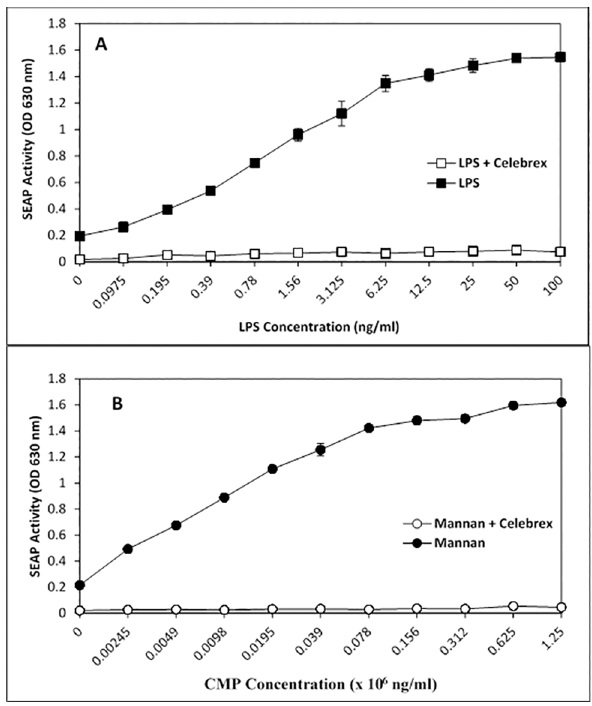
Fig 6. Celecoxib inhibits TLR4 activation. HEK-TLR4 cells were treated with media (filled symbols) or 100 μ M celecoxib(Celebrex; open symbols) prior to LPS (A) or CMP (B) stimulation.SEAP activity was measuredafter overnight incubation.